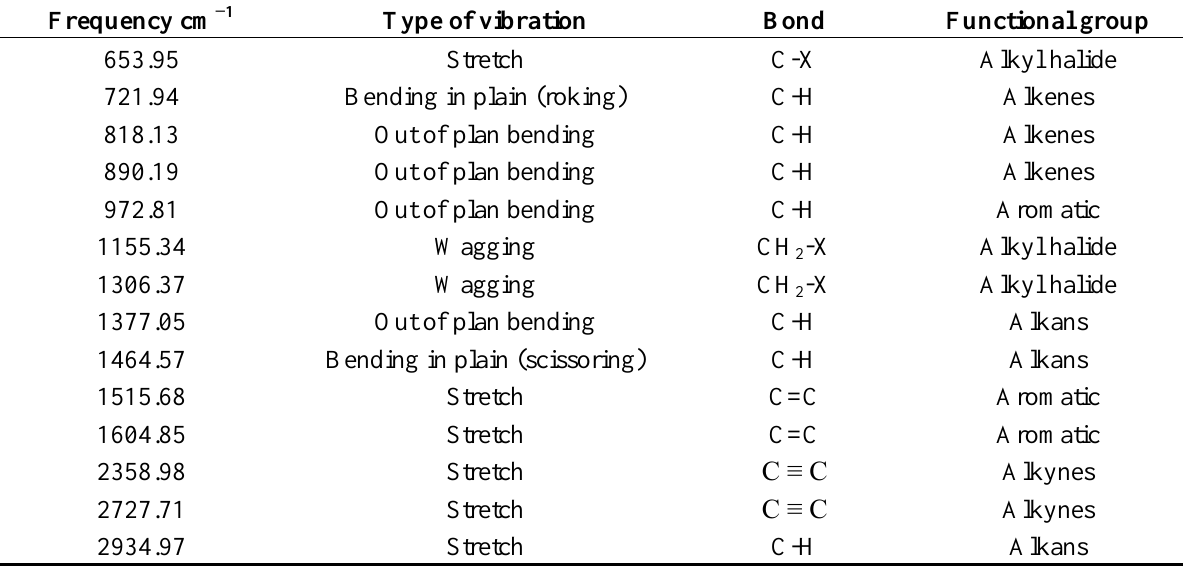
Table 8. Results of analysis of base oil (Ravenol, VSi SAE 5W-40). Frequency cm